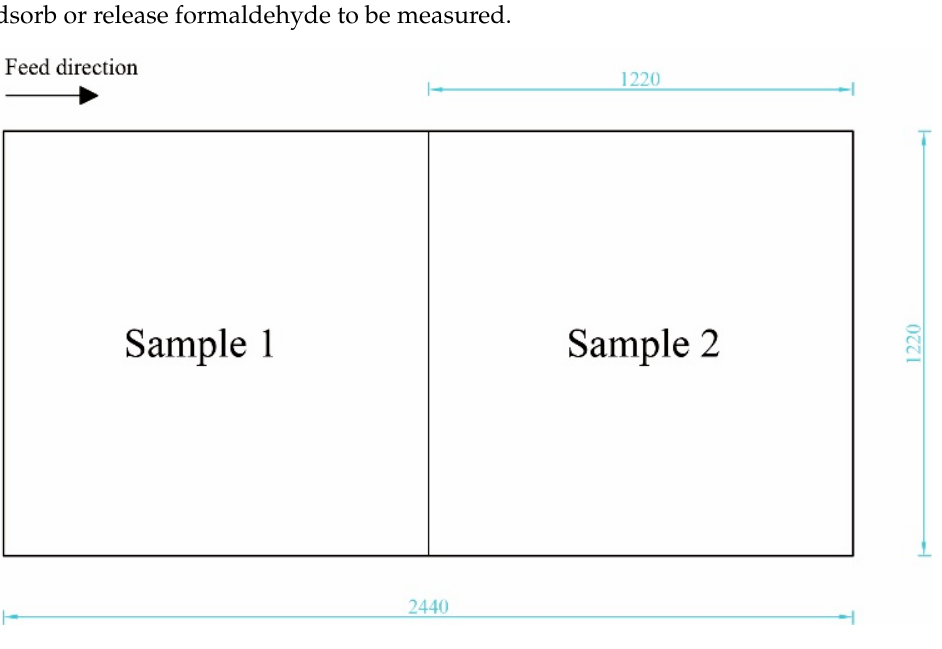
Figure 1. Sample preparation.